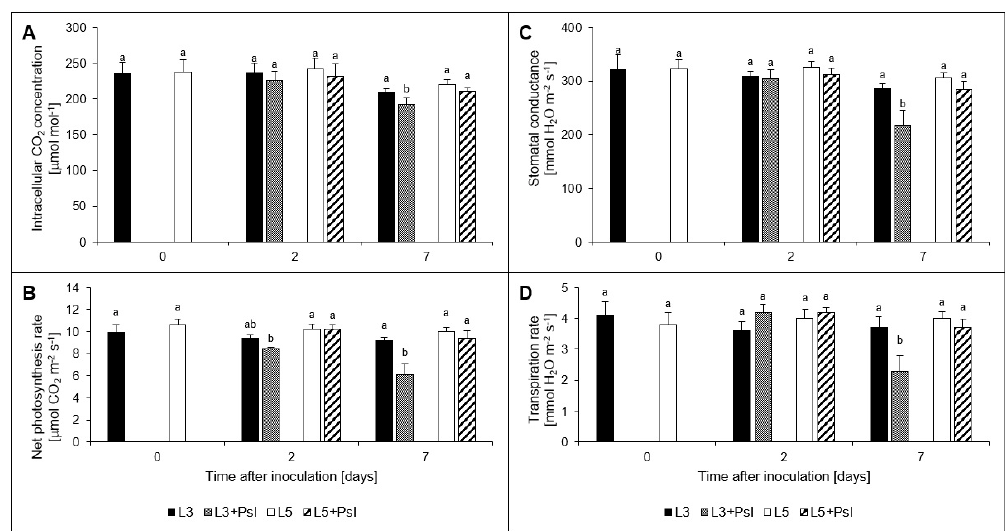
Figure 3. Gas exchange parameters: ( A ) intracellular CO 2 concentration (C i ), ( B ) net photosynthesis rate ( P N ), ( C ) stomatal conductance (G S ), ( D ) transpiration rate ( E ). Values are means of four replicates (±SD). Different letters (a – b) indicate significant ( p ≤ 0.05 ) differences between experimental variants within a given time point.